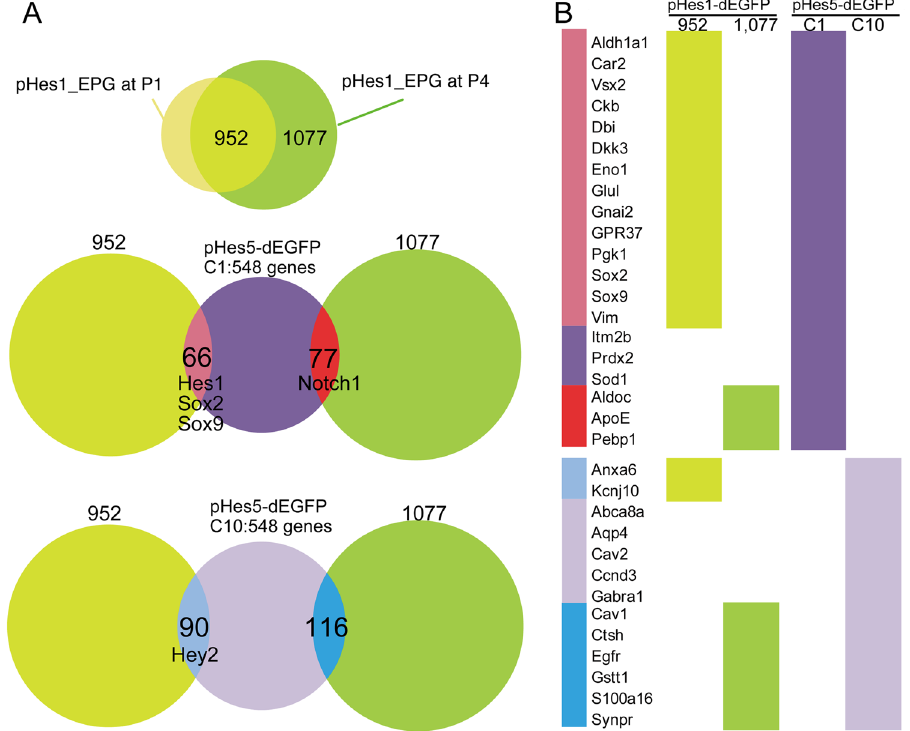
Figure 7. Comparison of gene expression patterns of pHes1-EGFP positive cells and pHes5-EGFP positive cells. ( A ) Schematic diagram of comparison of the gene expression. Venn diagram showing overlapping of genes of pHes1-EPG at P1 and P4 (upper panel), and these genes with pHes5-EGFP C1 genes 27 (middle panel), and these genes with pHes5-EGFP C10 genes 27 (lowest panel). ( B ) The genes enriched in Müller glia and/or in astrocytes 27 are shown in the left column, and colors in the right column indicate which subgroup the genes were found. CRLBP-1 and Gnb1l were not listed in both pHes1-EGFP and pHes5-EGFP gene